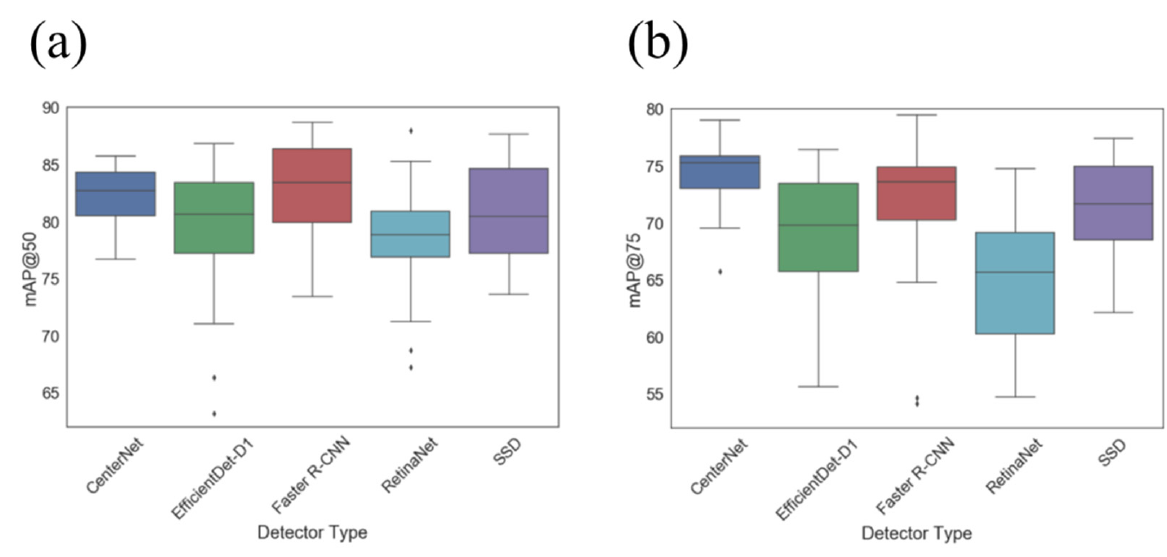
Figure 9. Box plot showing the performance of the different object detectors. ( a ) mAP@50; ( b ) mAP@75.